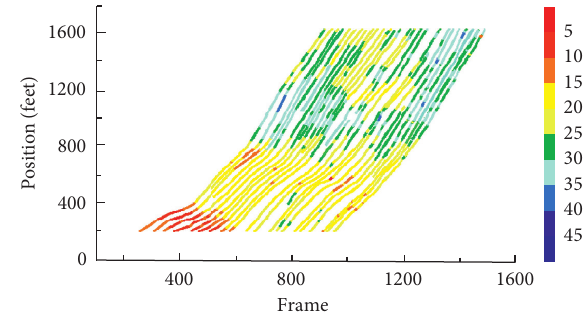
Figure 6: Vehicle track diagram (CLC).